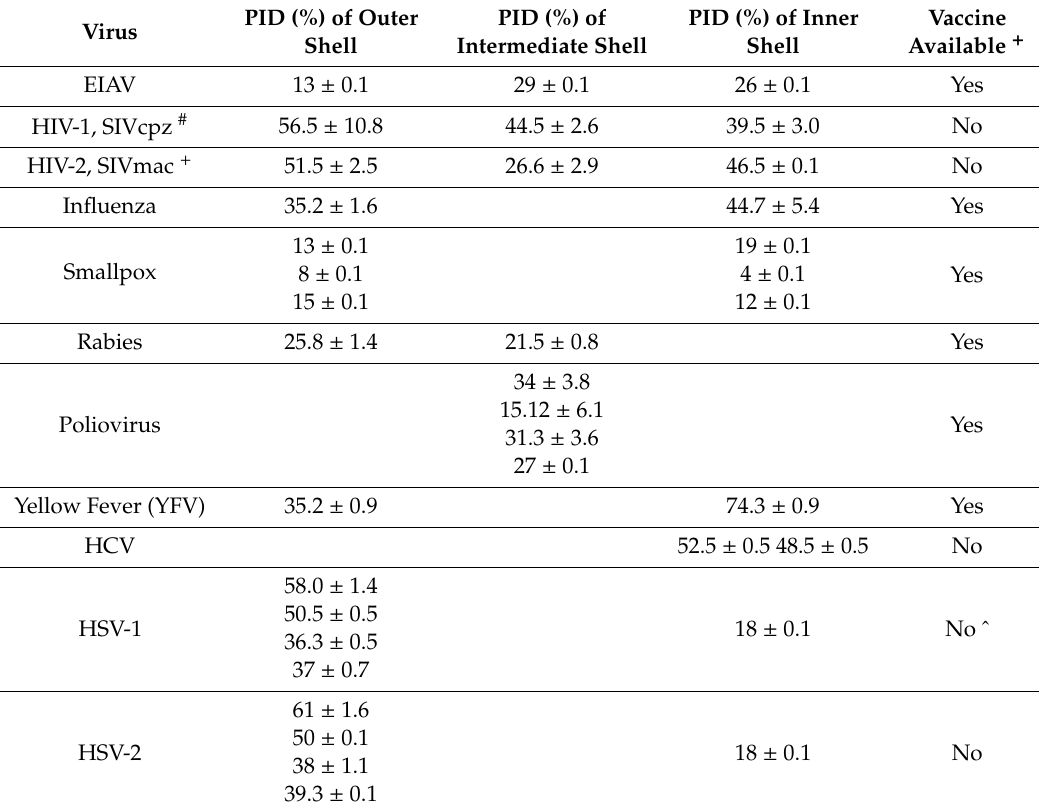
Table 2. Percentage of Intrinsic disorder (PID) levels of shell